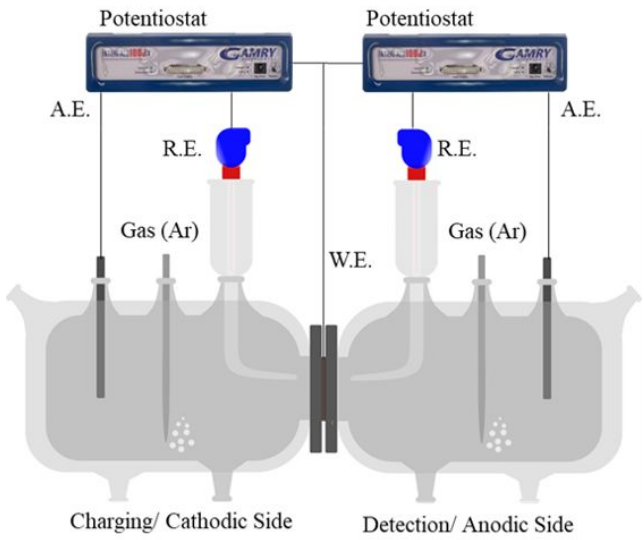
Figure 1. Schematic of the permeation cell used for this study. H + is reduced as H at the left com- partment and oxidized at the right compartment. The cell was home-made.